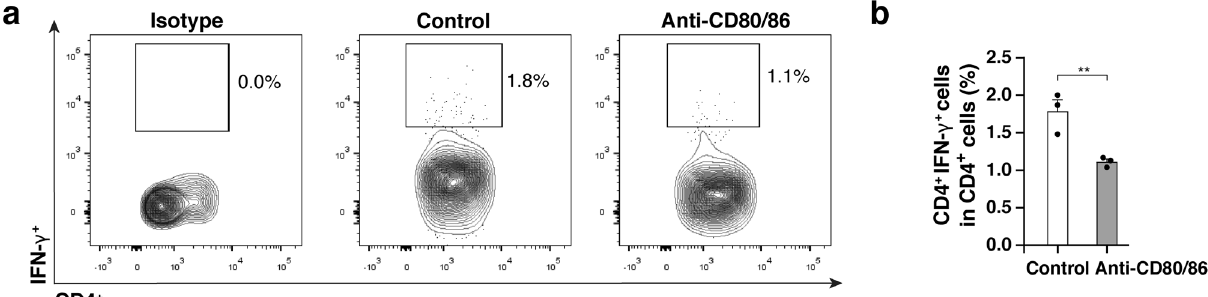
Figure 4. Anti-CD80/86 antibodies suppress IFN-γ-producing CD4 + T cells in corneal graft. ( a ) Representative flow cytometry plots of IFN-γ + CD4 + T cell frequency in the groups injected with anti-CD80/86 injection and phosphate-buffered saline (PBS). ( b ) Frequency of IFN-γ + CD4 + T cells in CD4 + T cells in the grafts of